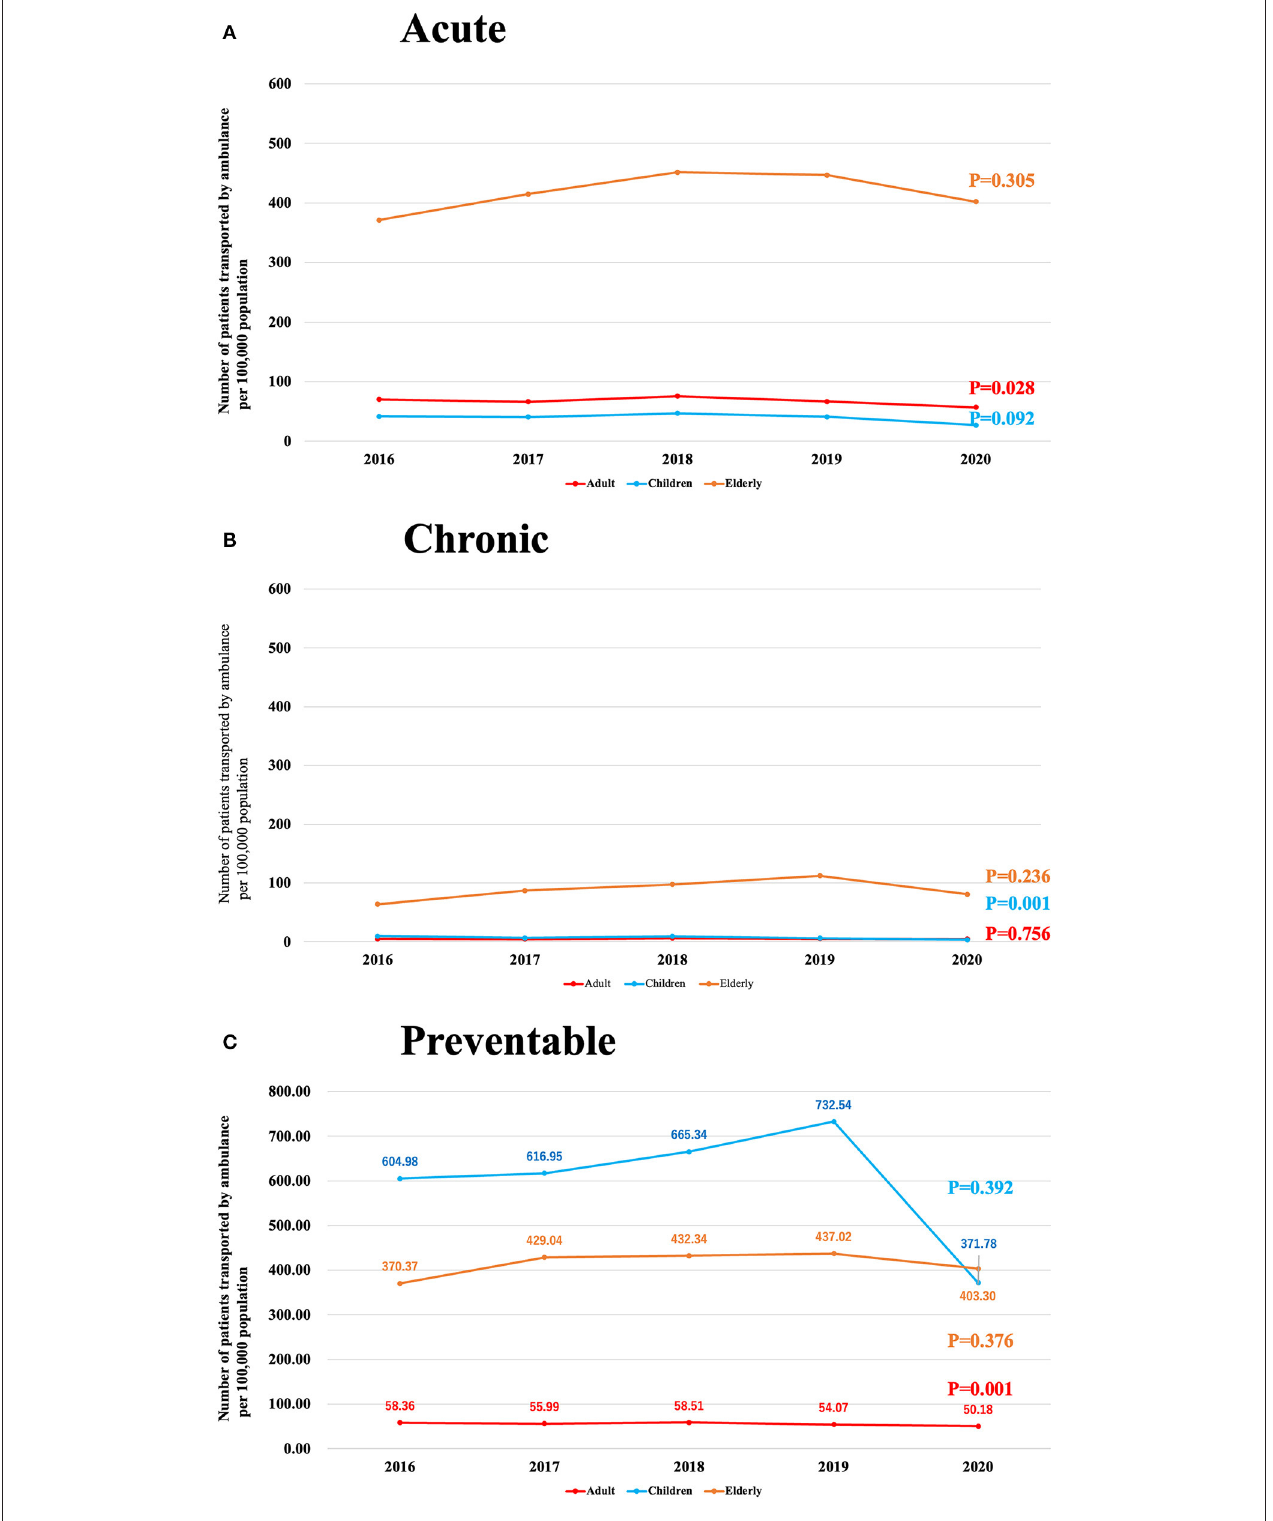
FIGURE 1 | (A) , Trends over time in the number of acute ACSCs patients transported by ambulance per 100,000 population. (B) , Trends over time in the number of chronic ACSCs patients transported by ambulance per 100,000 population. (C) , Trends over time in the number of preventable ACSCs patients transported by ambulance per 100,000